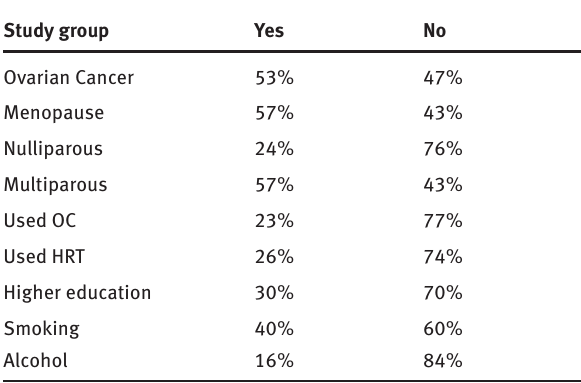
Table 5: Percentage distribution of the various risk factors in ovarian cancer and control